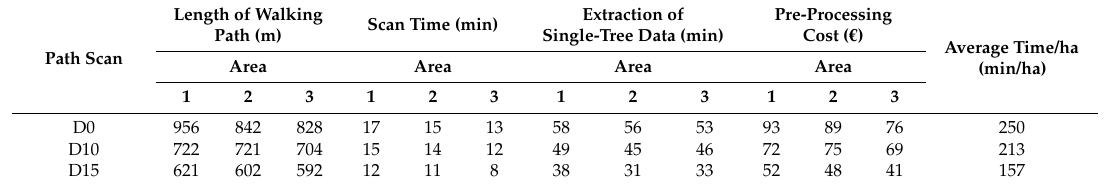
Table 2. Time and cost needed for HMLS (ZEB1) data acquisition and processing. Average time/ha column refers to the sum of scan time and extraction of single-tree data columns. Time is reported in minutes, length in meters, and costs in Euro.